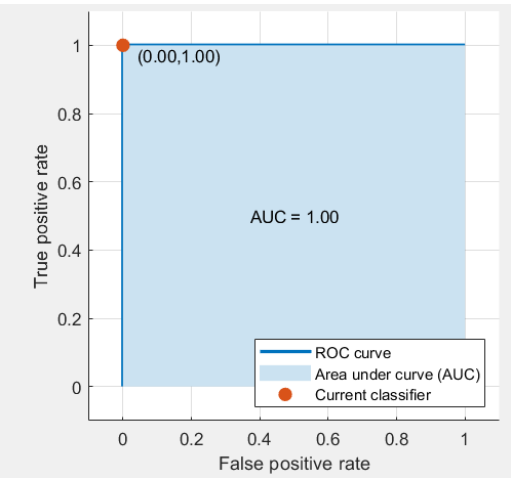
Figure 8. Receiver operating characteristic (ROC) curve of the results of a decision tree classifier.